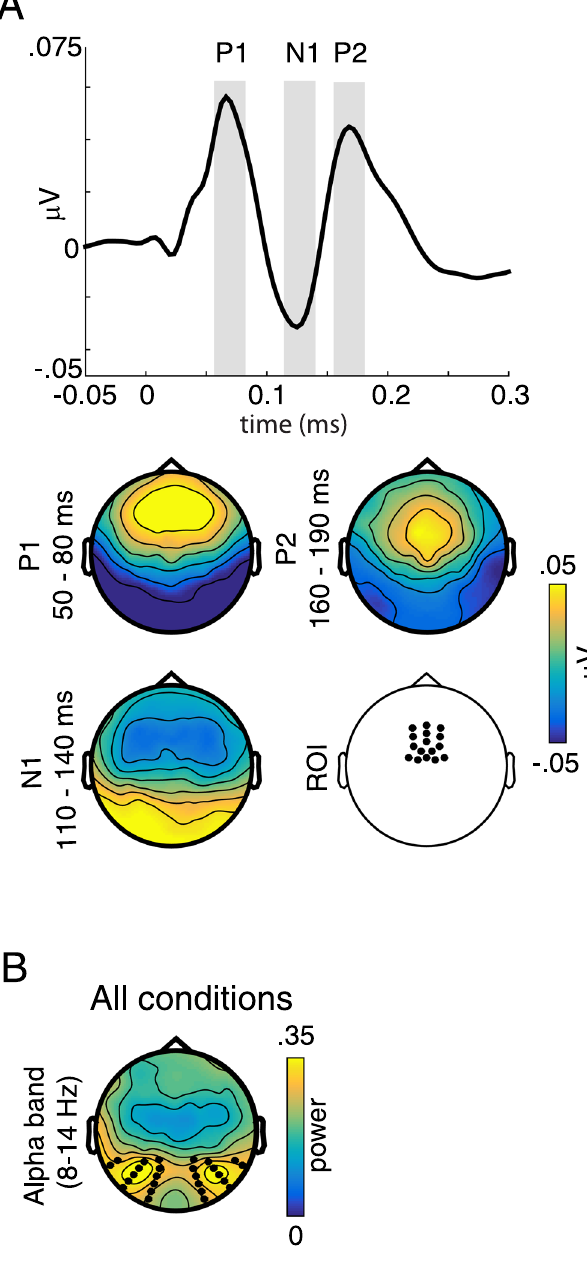
Figure 3. Definition of regions of interest (ROIs) for subsequent analyses. ( A ) Upper plot: Grand average event-related potential trace across all conditions, using a fronto-central ROI. Grey bars indicate time- windows of interest, selected around ( + / − 15 ms) the prominent P1, N1 and P2 peaks. Lower plot: Grand average topographies across all conditions of the three selected time-windows of interest, as well as topography indicating the pre-selected fronto-central ROI. (B) Topography of grand-average alpha-band power (8–14 Hz) across all conditions. Black dots indicate the channels used for statistical